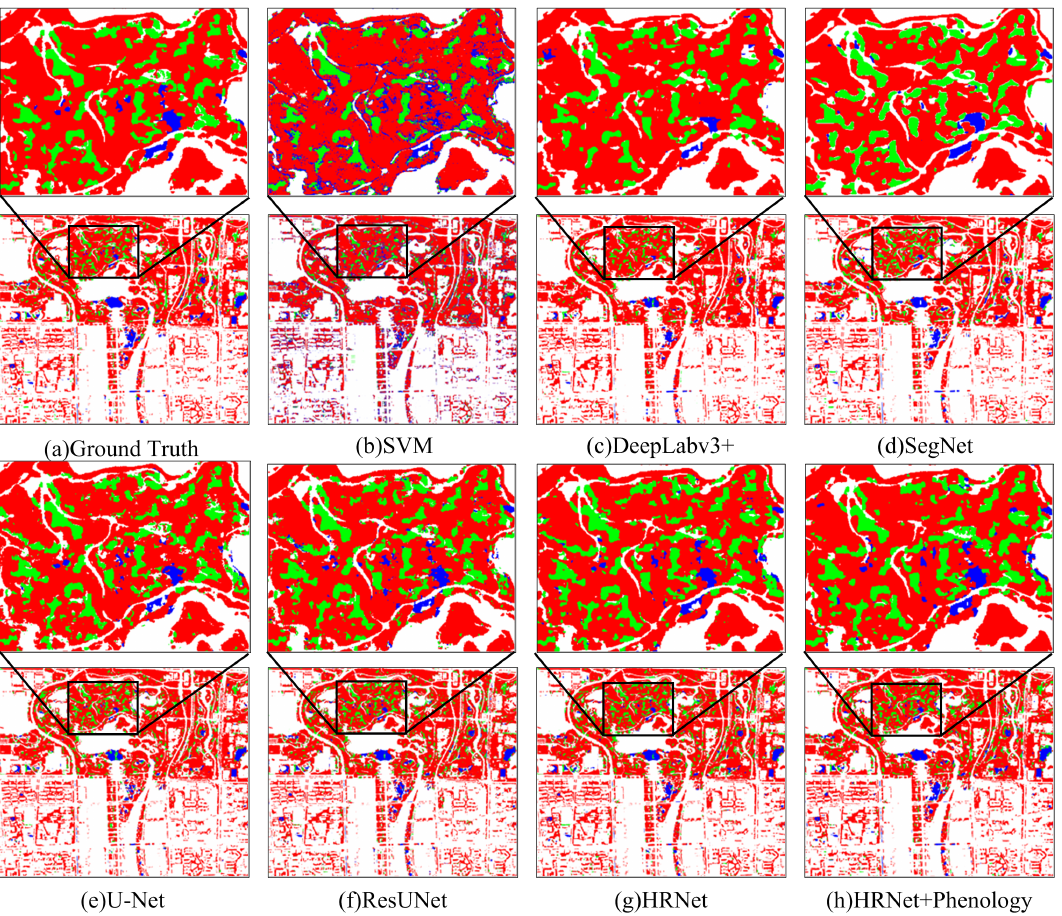
Figure 5. Comparison of the results of different classification